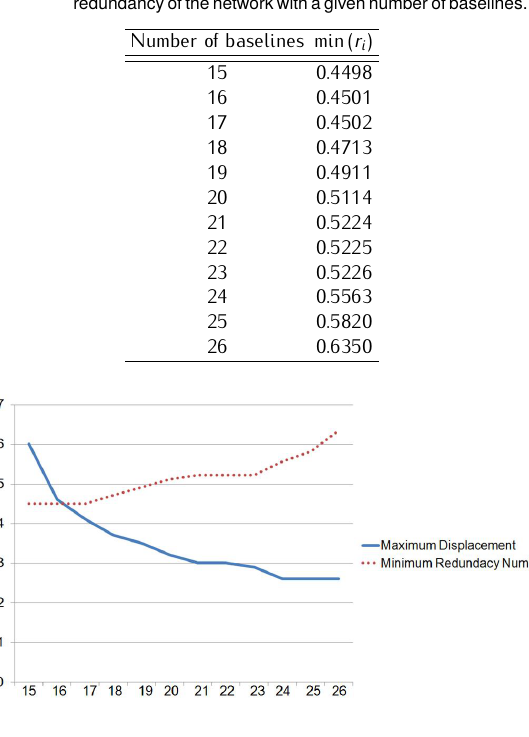
Figure 3. Maximum displacement value and minimum redundancy number as a function of increasing baseline